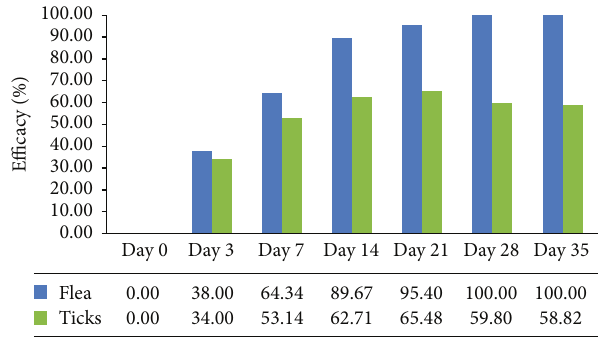
Figure 1: Efficacy (%) of Fiprofort Plus spot-on application against ticks and fleas during 35 days of the study.